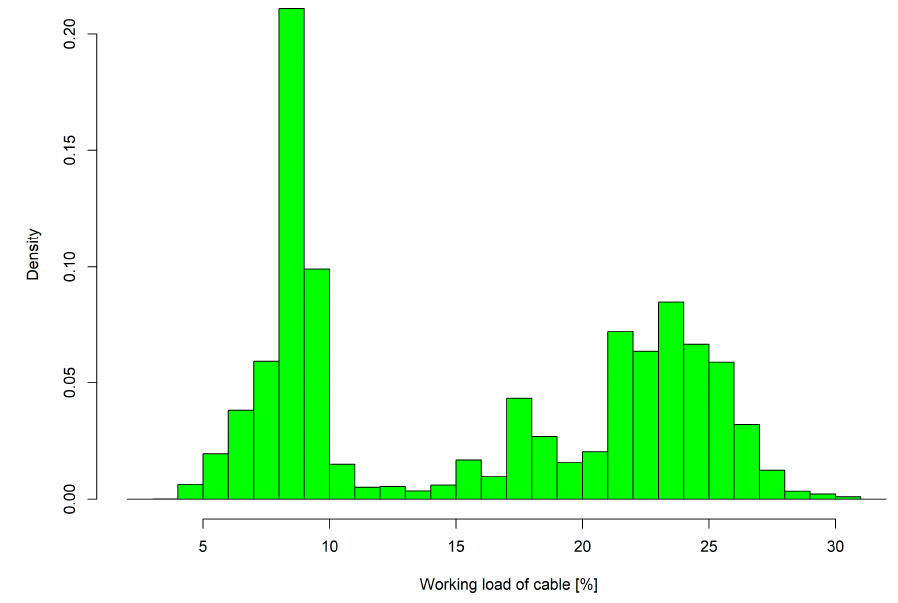
Figure 10. Working load of cable used during forwarding activities for all captured data.